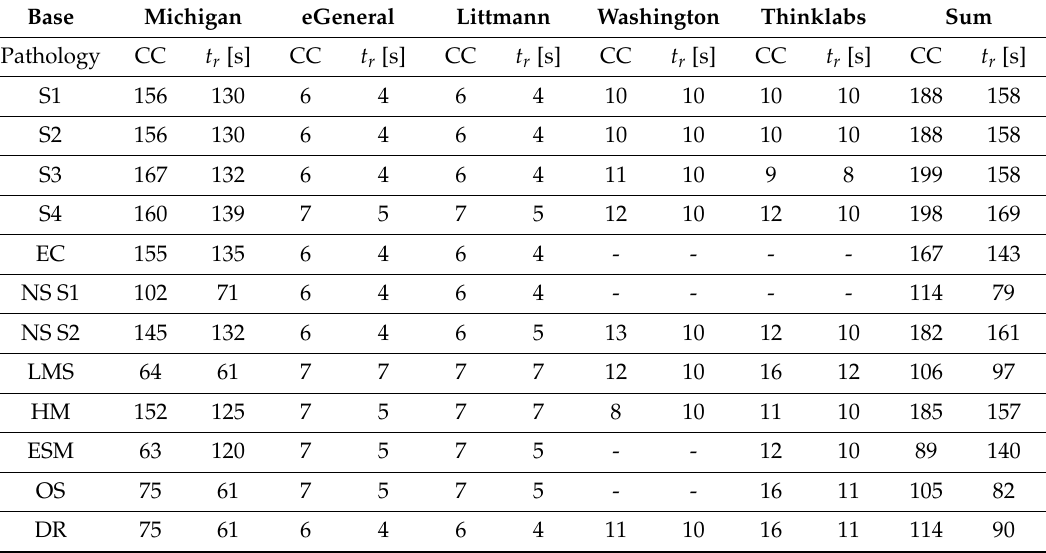
Table 1. Details about the dataset used for the simulations and